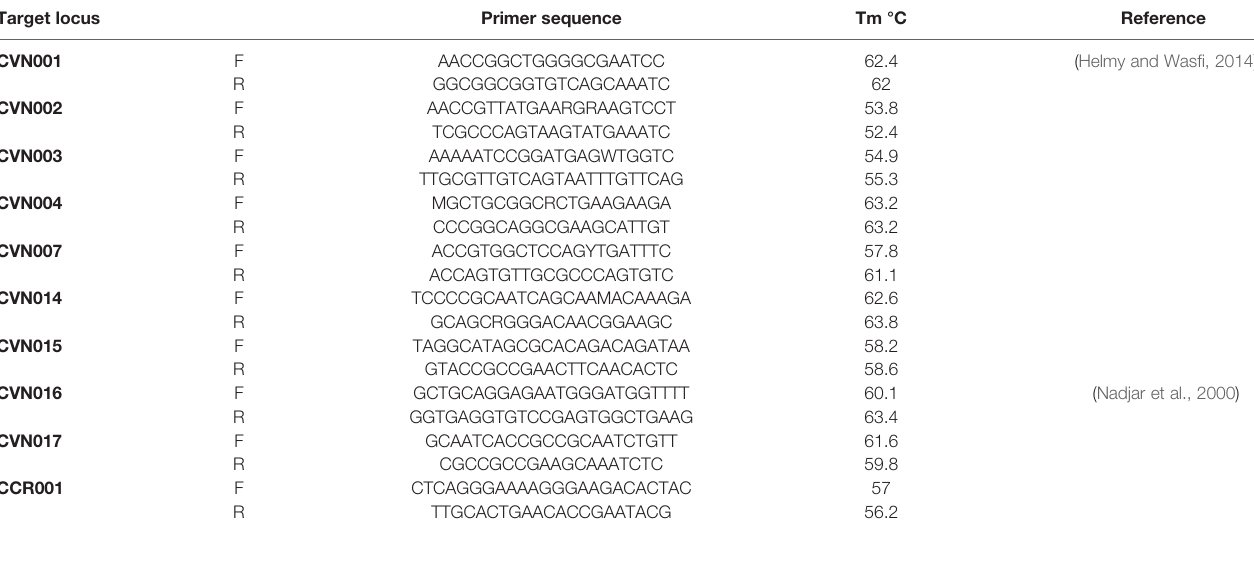
TABLE 2 | Primer sequences for MLVA technique. Target